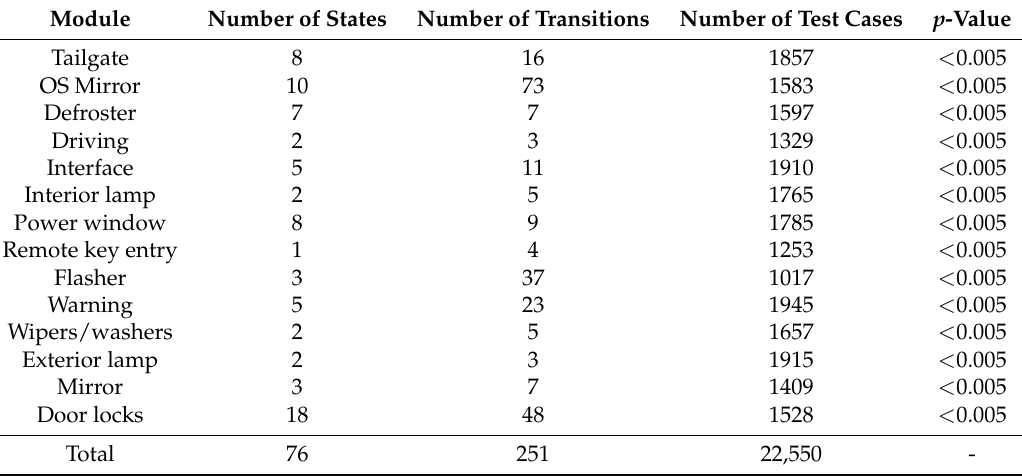
Table 6. Functionalities of the body control model